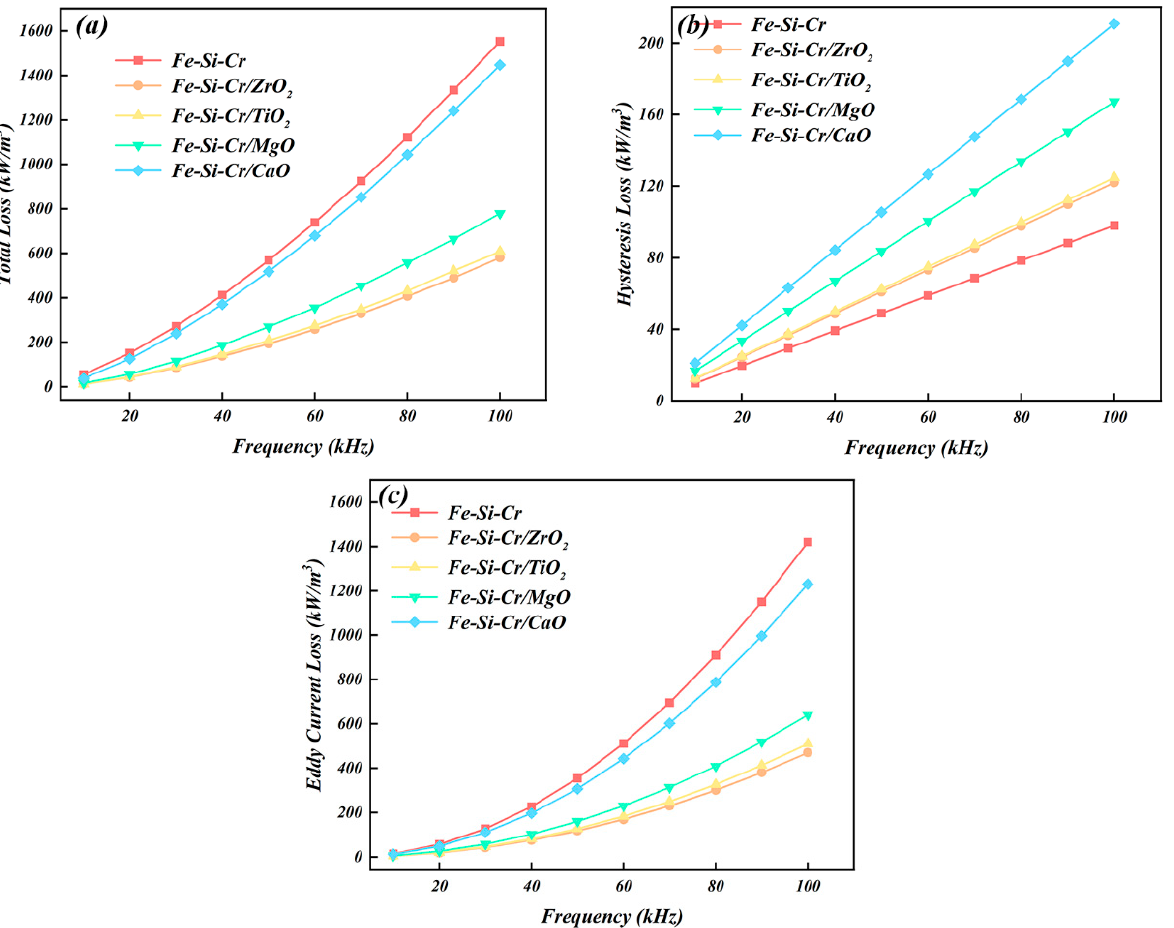
Figure 7. ( a ) Total loss, ( b ) hysteresis loss, and ( c ) eddy current loss of Fe-Si-Cr soft magnetic core and Fe-Si-Cr/AO x soft magnetic composite cores at 10 mT.